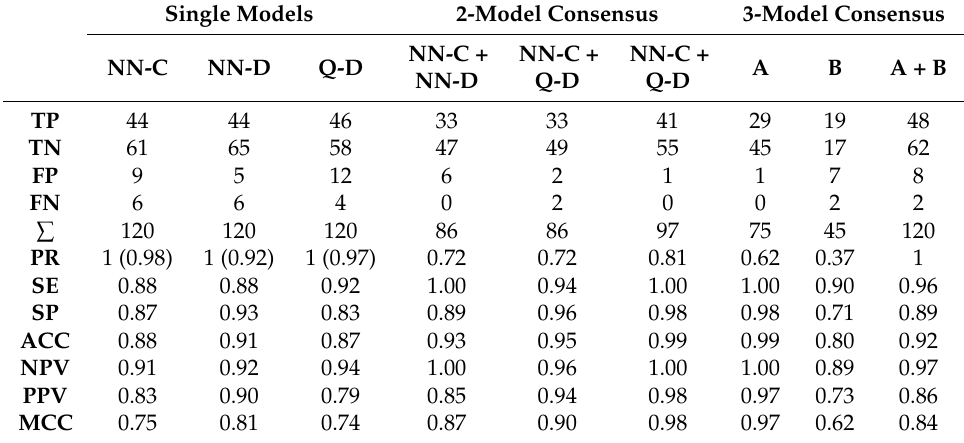
Table 1. Statistic parameters of the best three single models and consensus classification models.